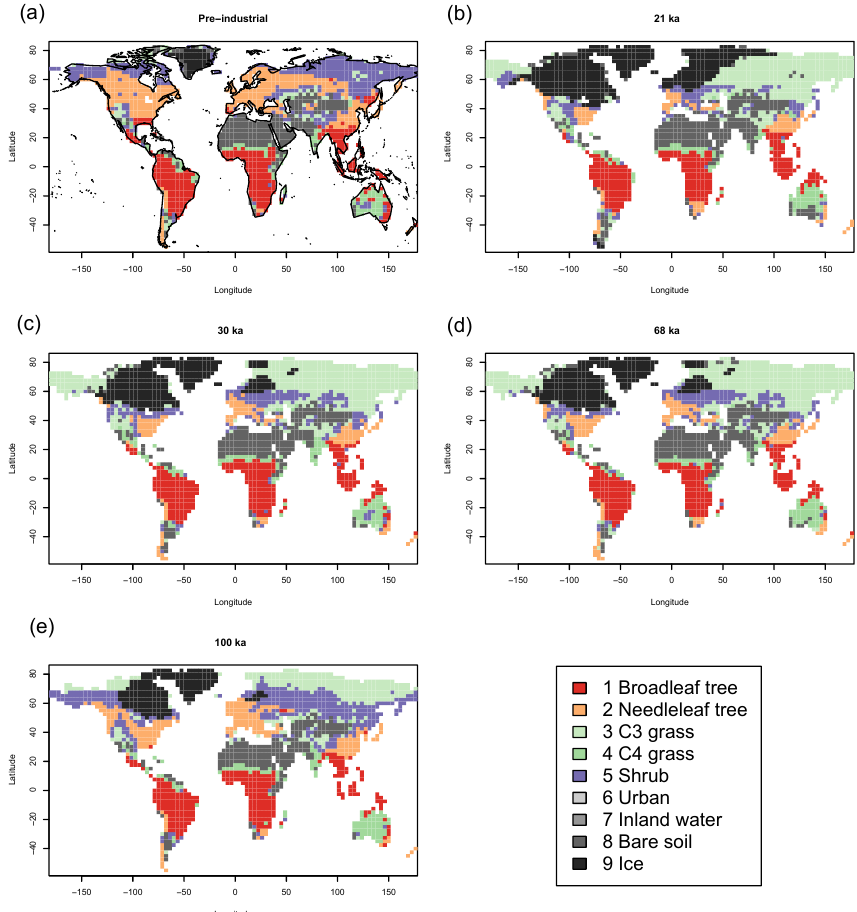
Figure 1. Dominant plant functional type (PFT) for some time periods of interest in the 120kyr covered by the simulations. (a) Pre-industrial, (b) 21ka, (c) 30ka, (d) 68ka, and (e) 100ka. Note that the dominant PFT is calculated as the land cover with the highest proportion of cover, compared to the other land surface types, and does not necessarily indicate the highest or a significant amount of net primary productivity